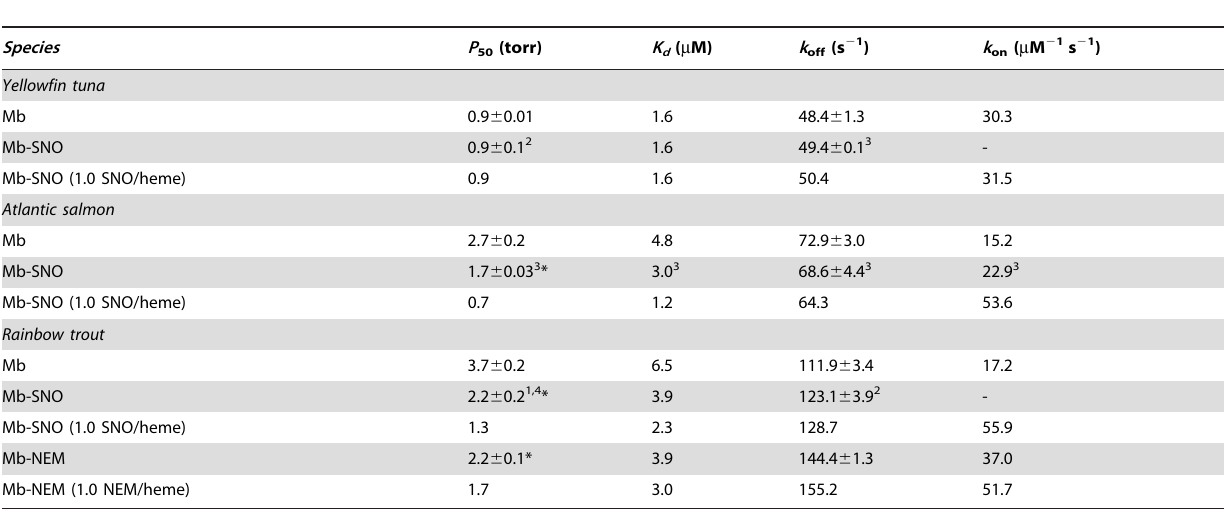
Table 1. Measured O 2 affinities ( P 50 ) and kinetic O 2 dissociation rates ( k off ) (means 6 SD; n =3) and derived O 2 dissociation equilibrium constants ( K d ) and apparent kinetic O 2 association rates ( k on ) for myoglobins from yellowfin tuna, Atlantic salmon and rainbow trout in the native (Mb) and thiol-modified forms (Mb-SNO and Mb-NEM).